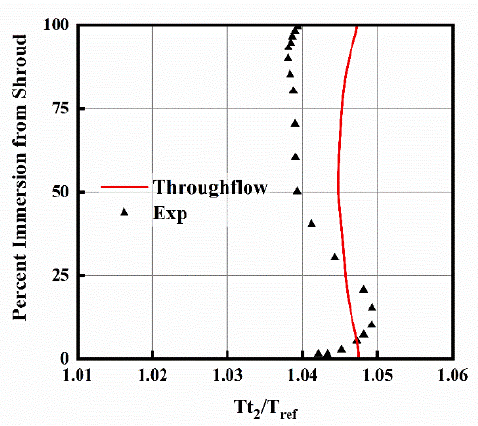
Figure 6. Comparison of total temperature ratio for LSCC.